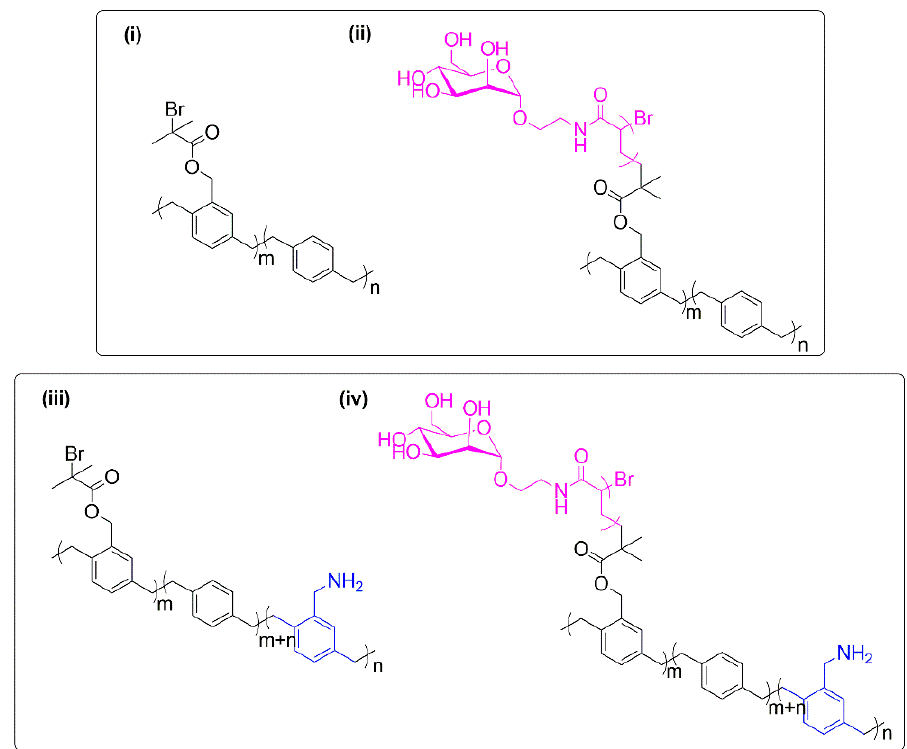
Figure 9. Structures of antiviral glycopolymer brushes prepared by combination chemical vapor deposition polymerization and SI-ATRP: (i) and (ii) reference polymer and correspondent mannose-based glycopolymer brush, respectively; (iii) and (iv) reference copolymer and correspondent mannose-based glycopolymer brush, respectively [18].